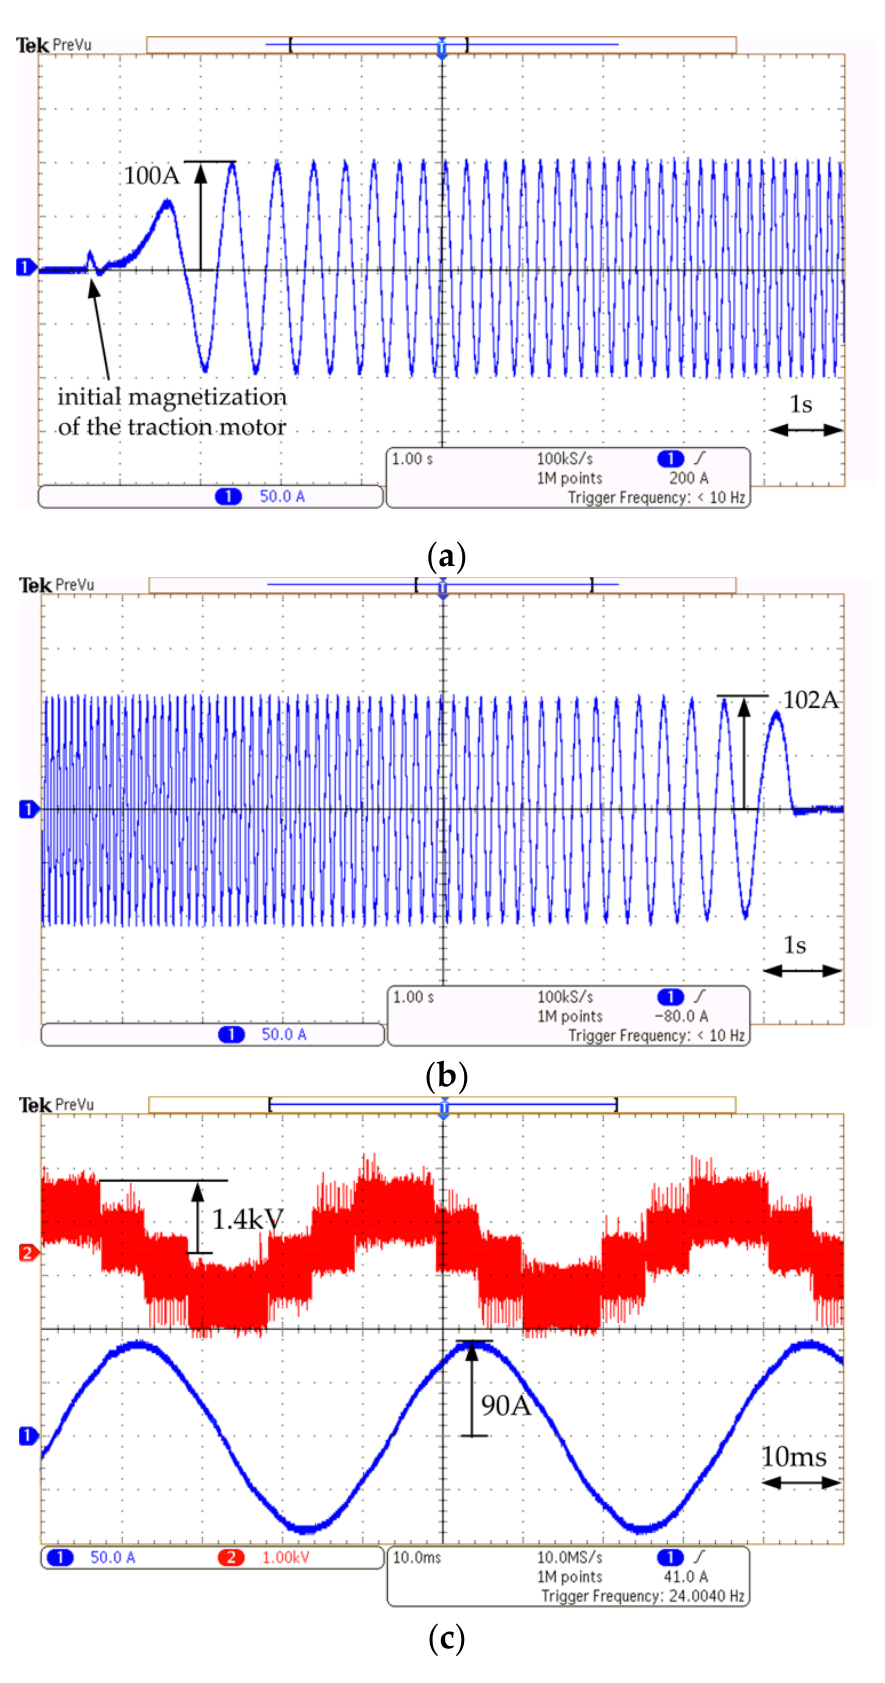
Figure 21. Traction motor stator current and output PWM voltage waveforms obtained during three operation modes of the DC PETT: start-up and acceleration mode ( a ); braking ( b ); phase voltage and phase current of the traction motor steady-state operation ( c ).